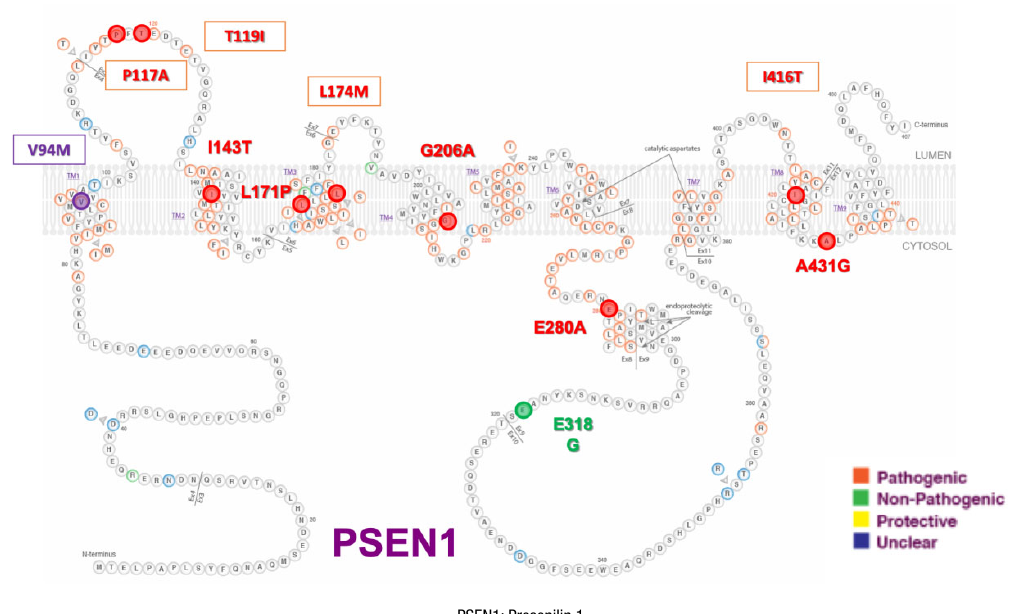
Figure 1. Latin American Presenilin 1 mutations.